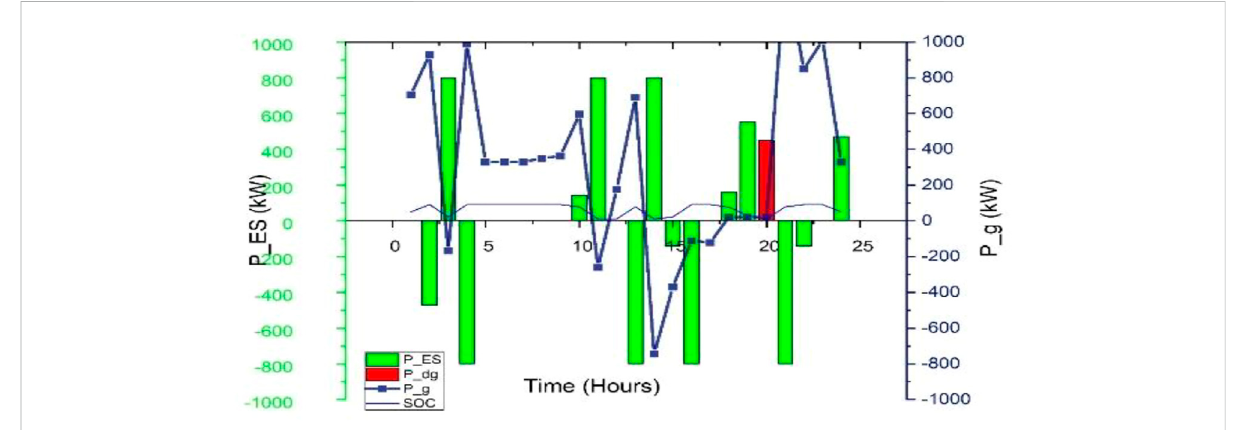
FIGURE 8 Energy exchange in the ESS scenario.